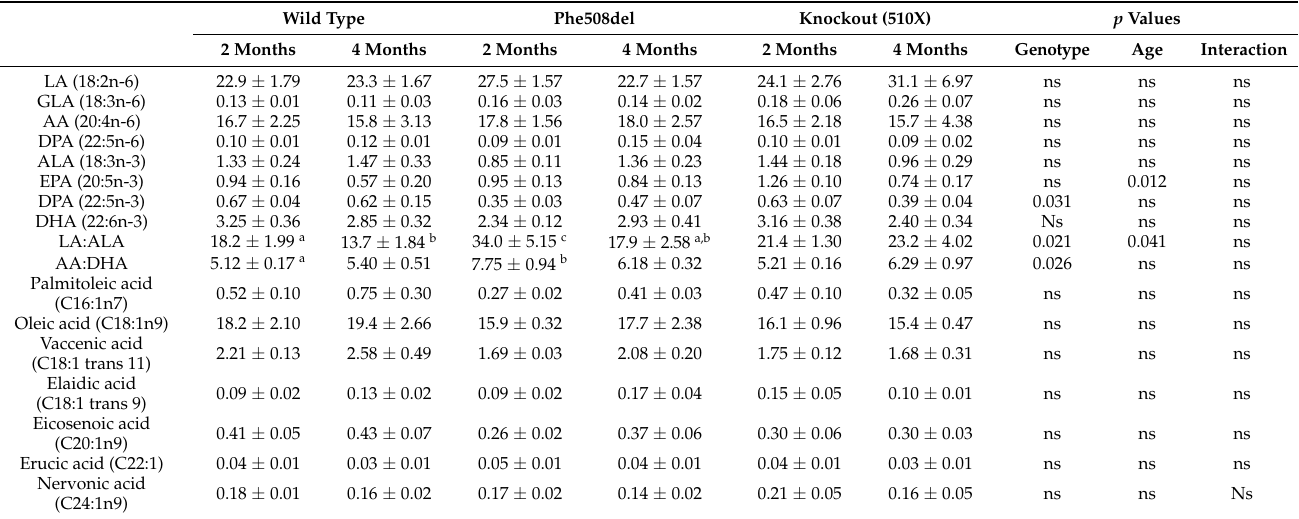
Table 1. Fatty acid composition in the serum of CF rat models.